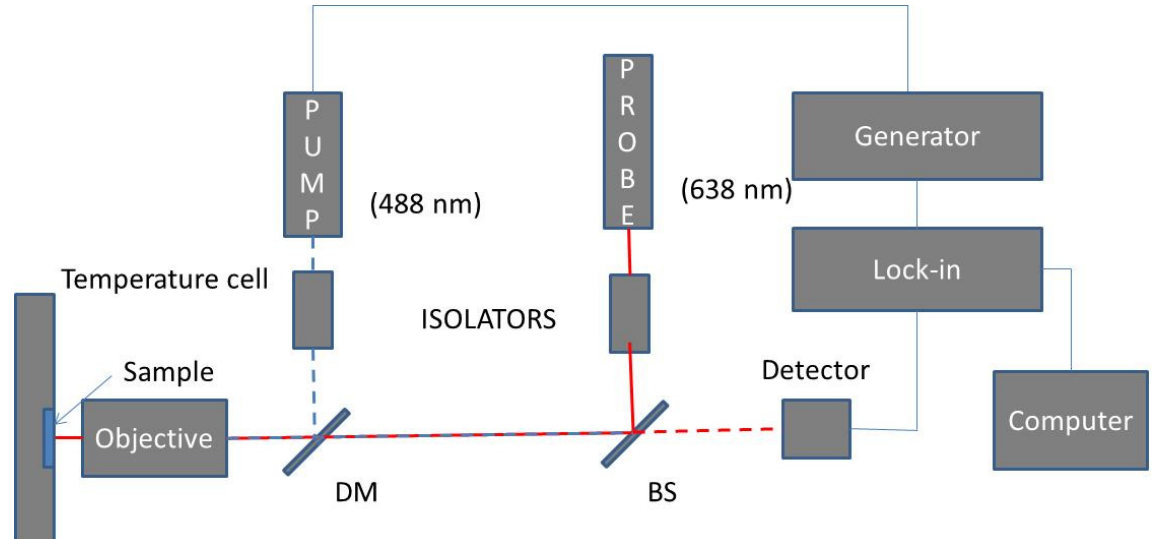
Figure 3. FD-TR setup.